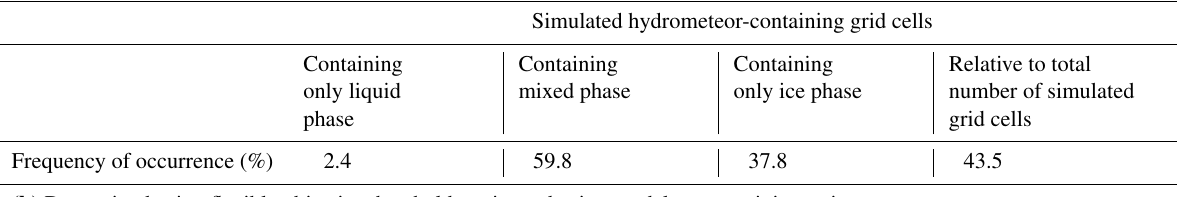
Table 1. (a) Hydrometeor-phase frequency of occurrence obtained (a) from ModelE mixing ratios outside of the forward-simulator frame- work and (b–c) from the forward-simulation ensemble created using different backscattered power assumptions. The median and interquartile range (IQR) capture the statistical behavior of the ensemble. Results using thresholds (b) objectively determined for each forward-ensemble member and (c) modified from those in Shupe (2007). Percentage values are relative either to the total number of simulated hydrometeor- containing grid cells (426603) or those grid cells with detectable hydrometeor amounts (333927). Note that the total number of simulated grid cells analyzed is